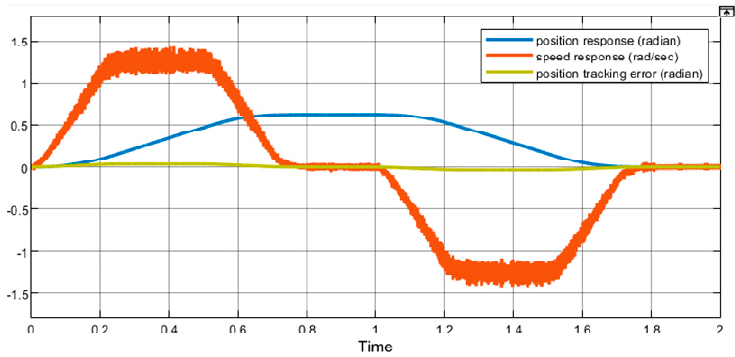
Figure 10. The simulated position, speed and position tracking error.